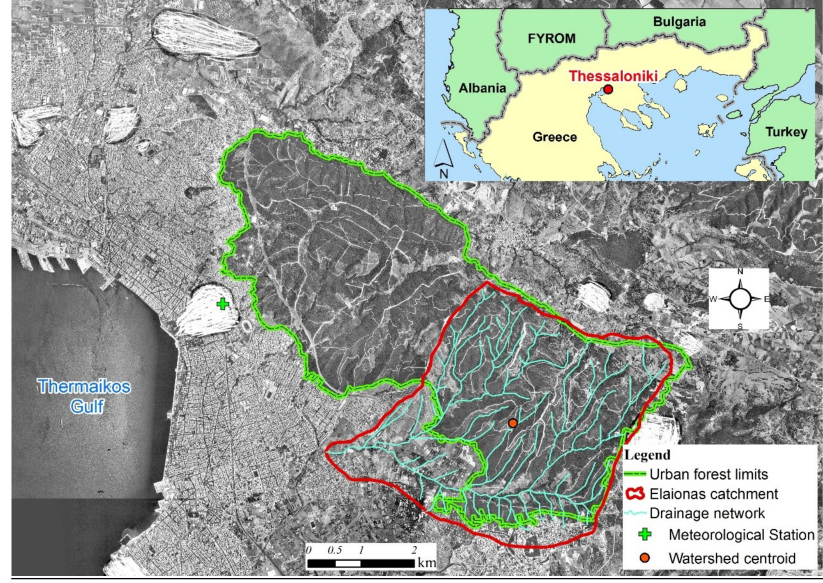
Figure 1. Location map and spatial location of the rainfall gauge (images courtesy of National Cadastre and Mapping Agency